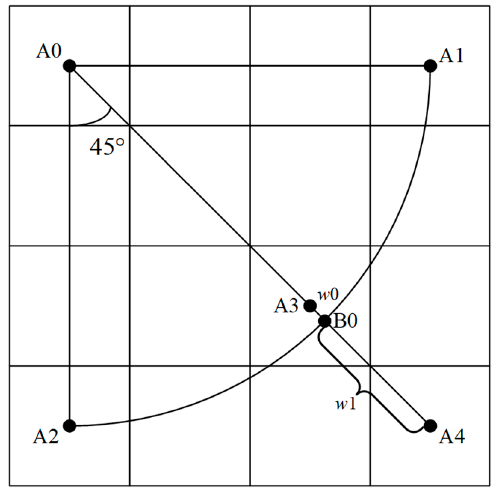
Figure 3. Definition of 45° matching pixel point when calculating co-occurrence